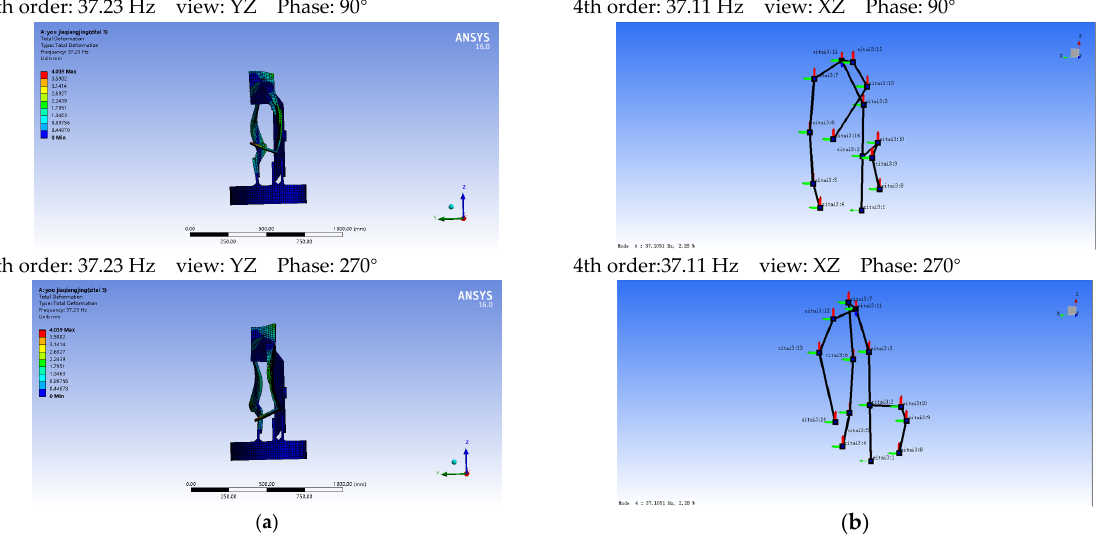
Figure 6. ( a ) Fourth-order simulation mode diagram; ( b ) Fourth-order test mode diagram.